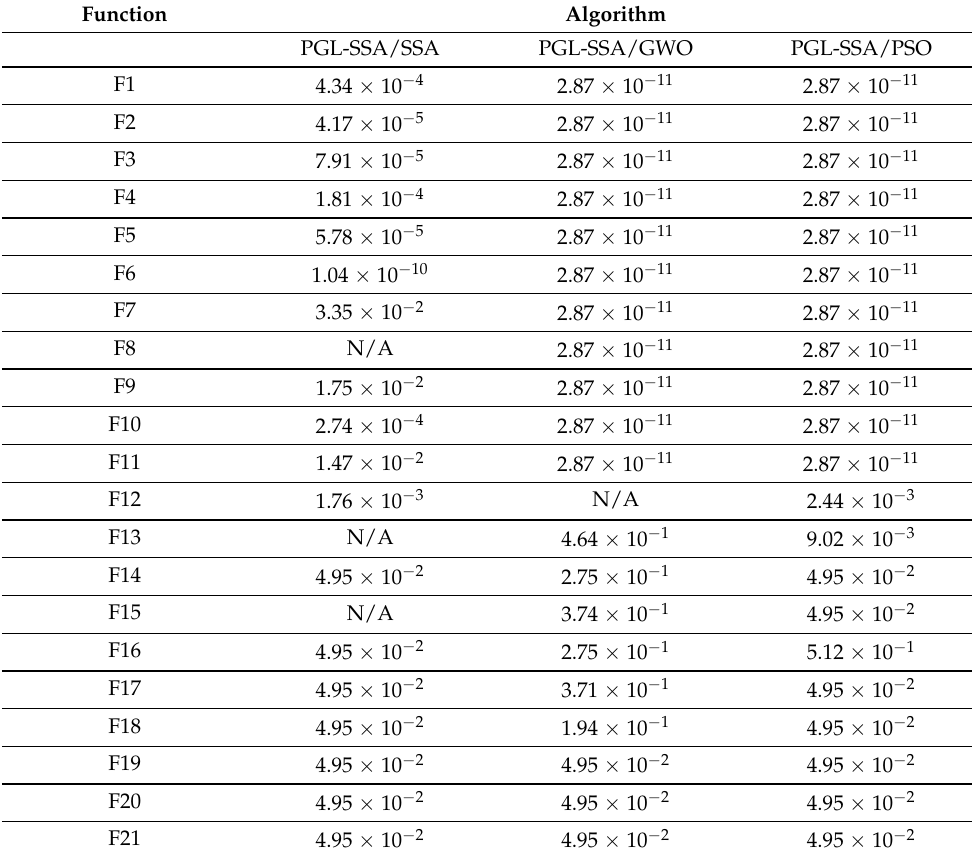
Table 4. Wilcoxon rank sum test for the test function. Function